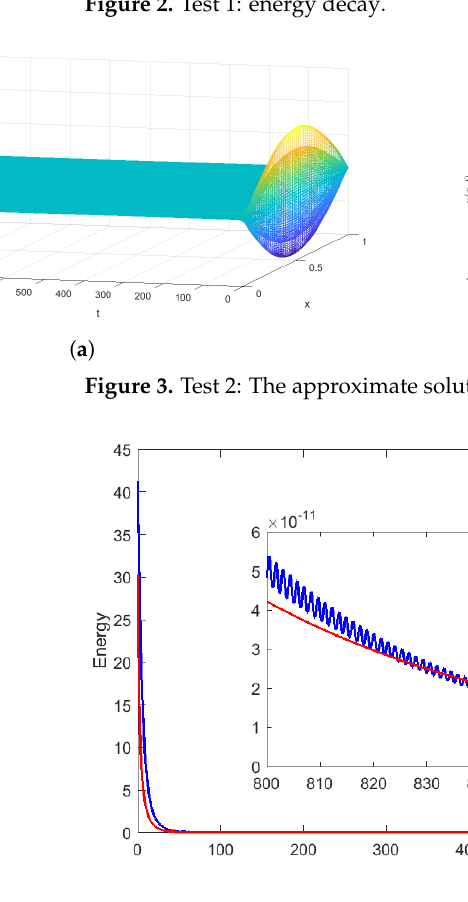
Figure 4. Test 2: energy